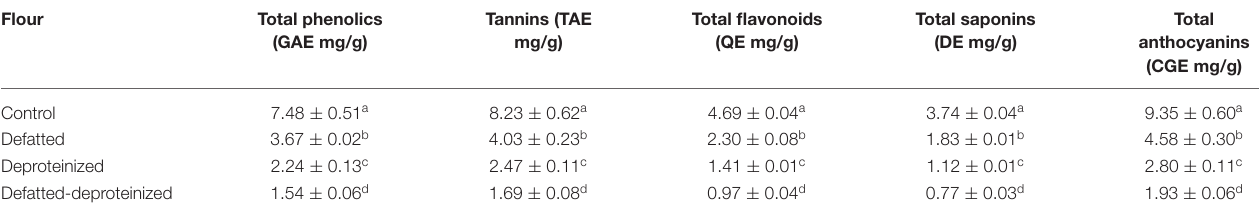
TABLE 1 | Bioactive constituents of control, defatted, deproteinized, and defatted-deproteinized sorghum flour. Flour